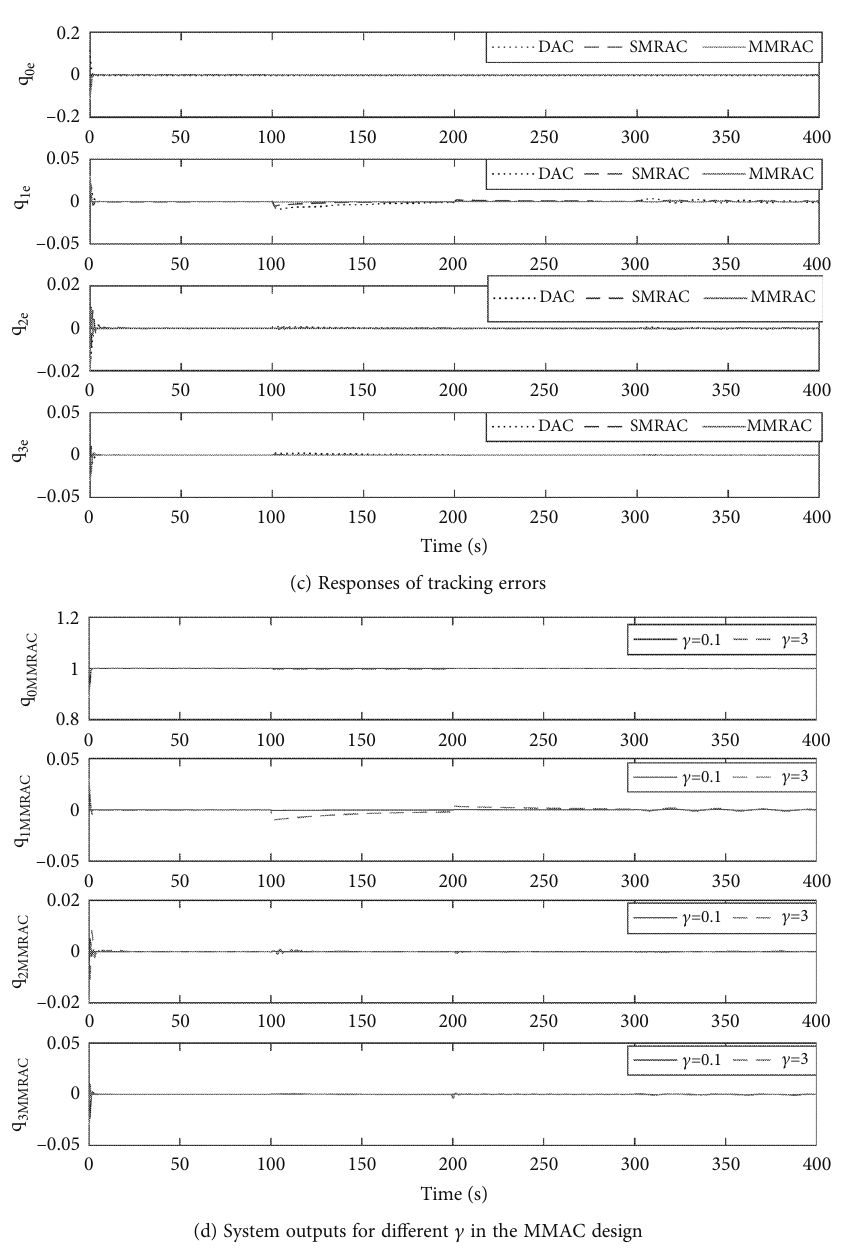
Figure 2: Attitude tracking control using MMRAC-, SMRAC-, and DAC-based fault-tolerant control schemes for Case